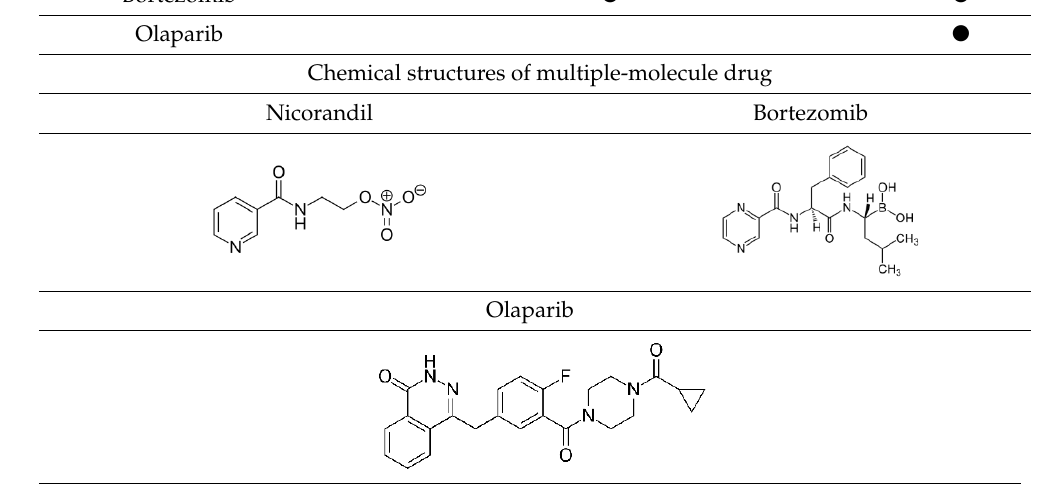
: The proposed small molecules to target the biomarkers (drug targets).